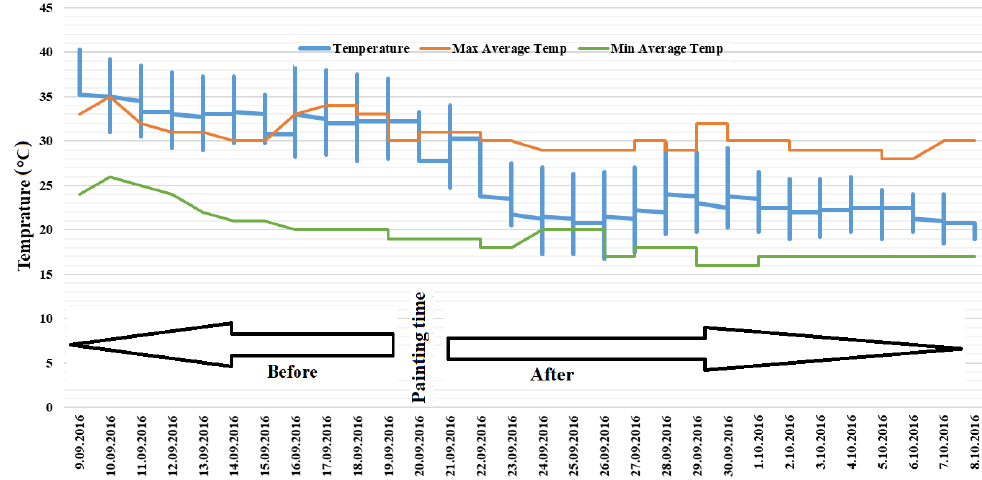
Figure 14. Measurement values of daily average and maximum/minimum temperatures for TR8.